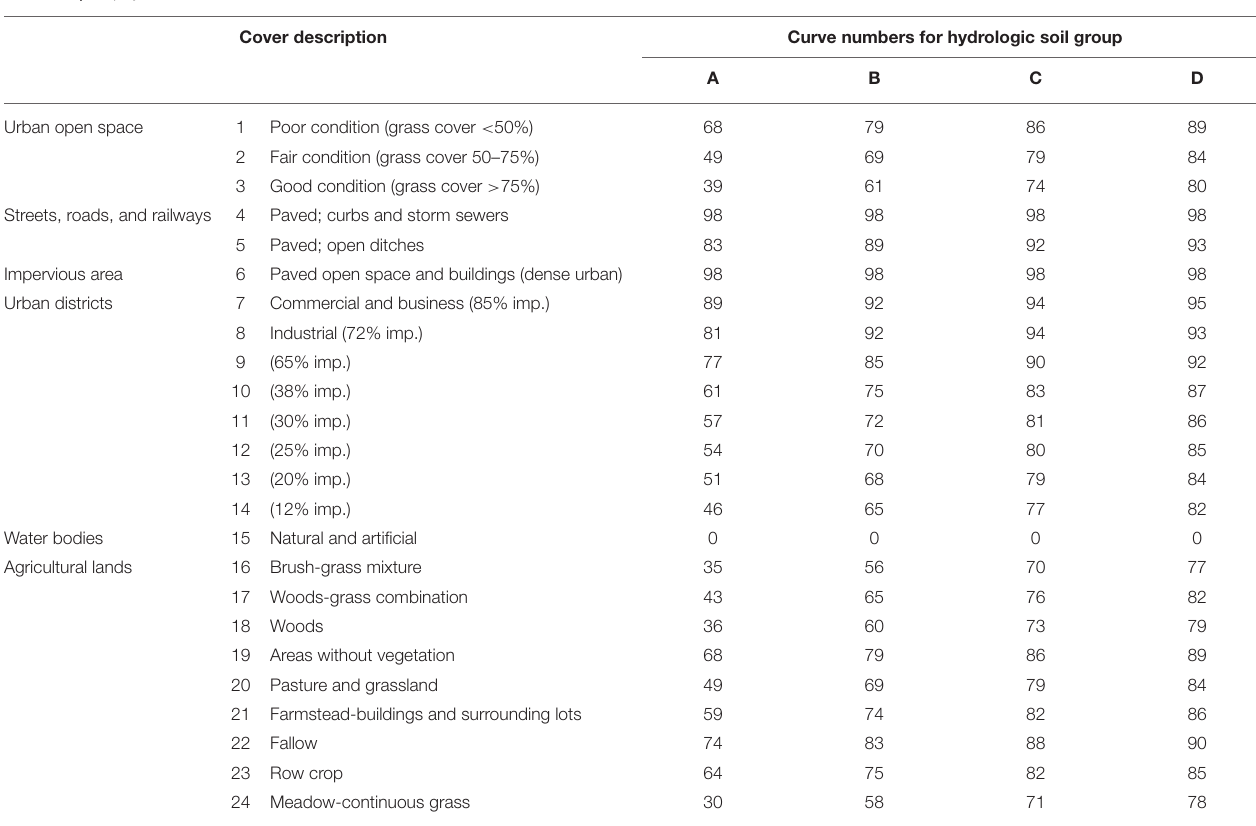
TABLE 3 | Biophysical table with land use and curve numbers. Cover description Curve numbers for hydrologic soil